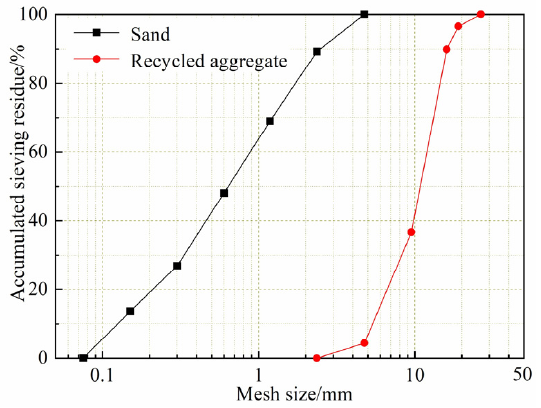
Figure 1. Grading curves of the aggregate. Table 1. Chemical component content of cementitious material (%).